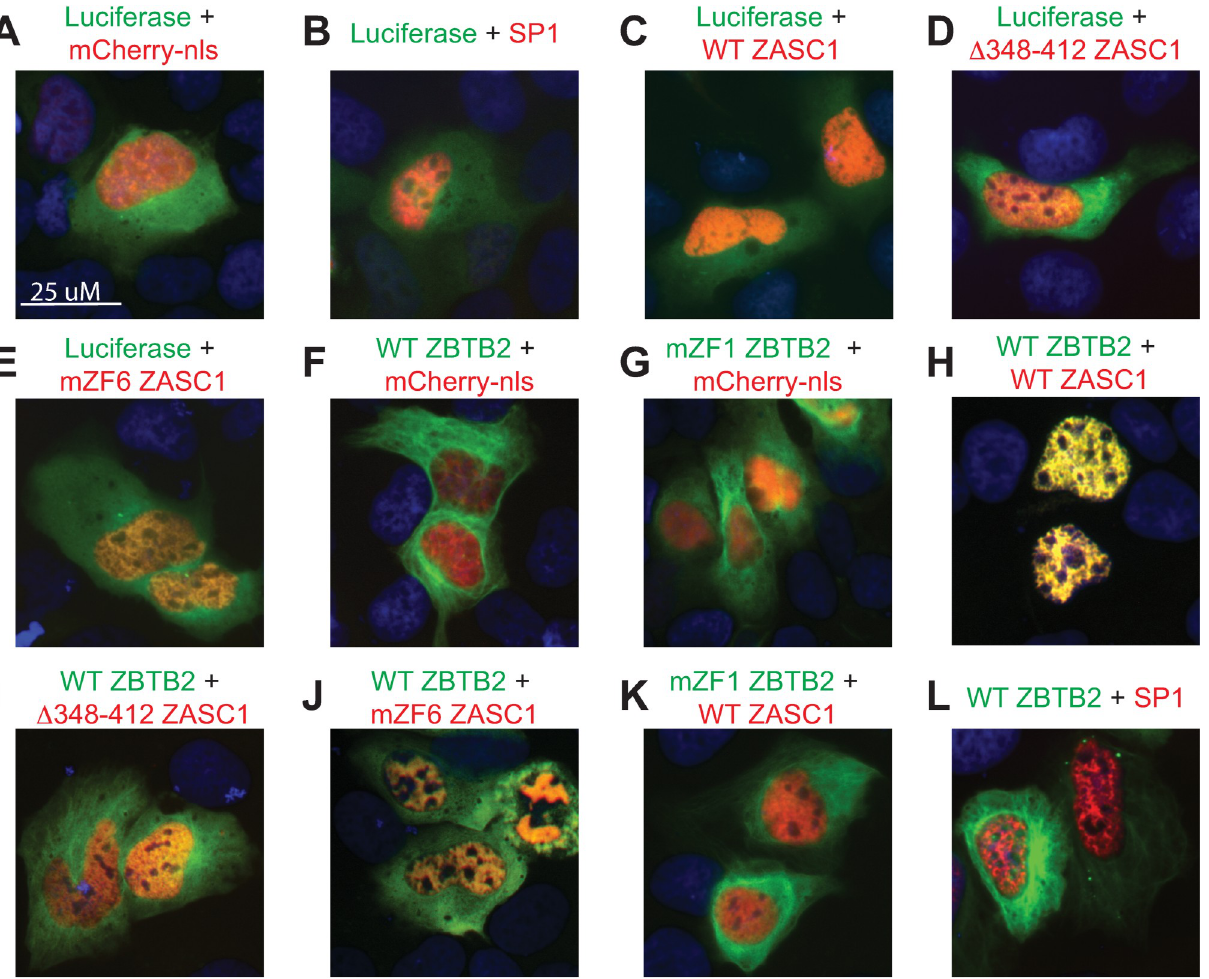
Fig 2. ZASC1 regulates ZBTB2 nuclear localization. Fluorescent images of U2OS cells transfected with expression vectors encoding the indicated mCherry-fusion proteins (mCherry with a nuclear localization signal, SP1 and ZASC1 variants) and GFP- fusion proteins (firefly luciferase and ZBTB2 variants). Nuclei were stained with DAPI. Scale bar applies to all